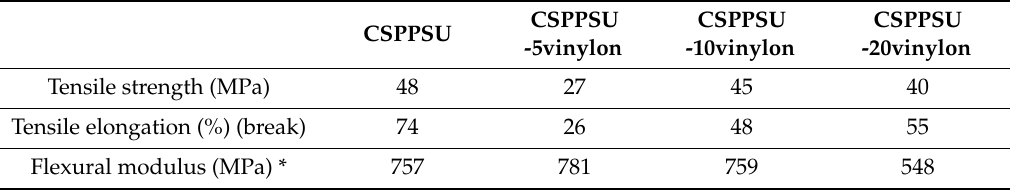
Table 4. Mechanical properties of CSPPSU-vinylon membranes.